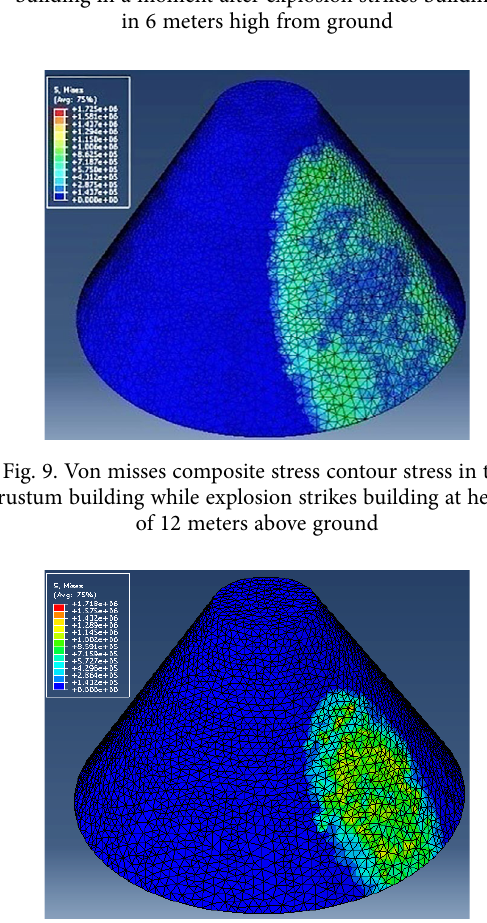
Fig. 10. Von misses composite contour in the frustum building in a moment after explosion strikes building at height of 12 meters above the ground